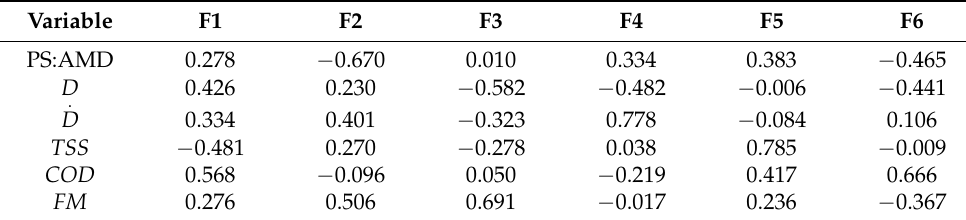
Table 7. Factor loadings based on PCA